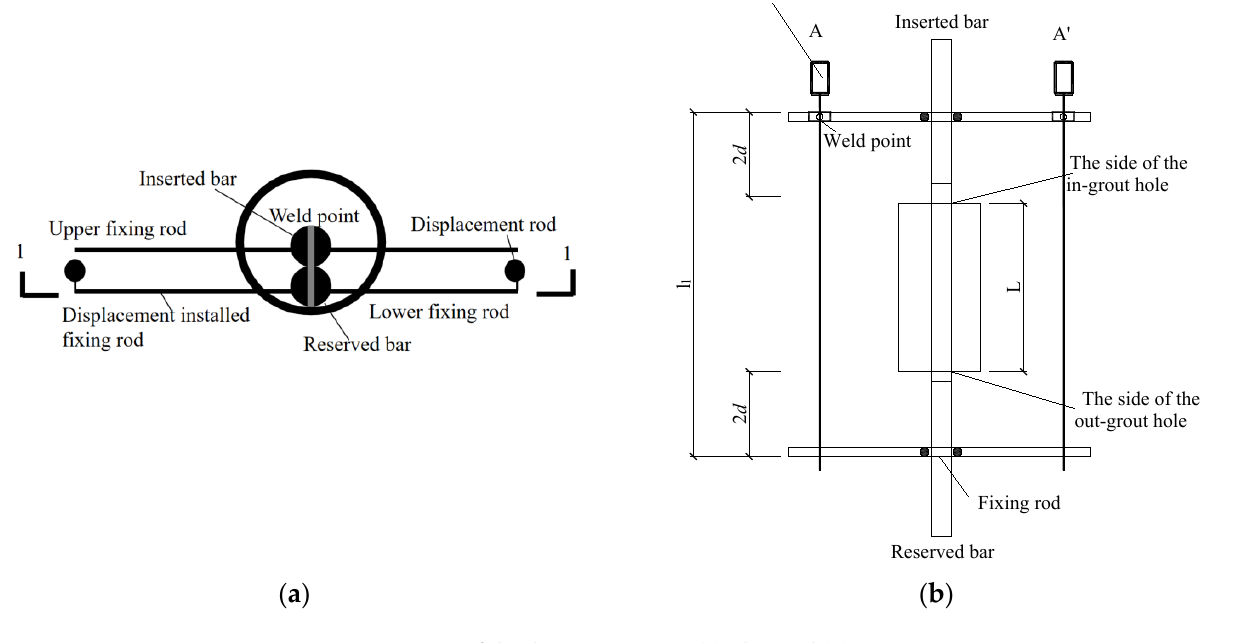
Figure 9. Schematic diagram of the layout of the strain gauges (unit: mm). ( a ) the front view and ( b ) Section 1-1. As shown in Figure 10, two displacement meters were arranged symmetrically on both sides of the steel bar of the specimen to measure the internal displacement within the gauge distance ( L 1 = L + 4 d ). Mechanical indices, such as the residual deformation of the connection, were calculated as the average value of the readings of the two displacement meters.